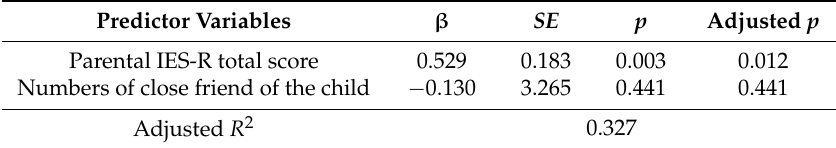
Table 5. Factors related to CBCL total problems by multiple regression analysis.